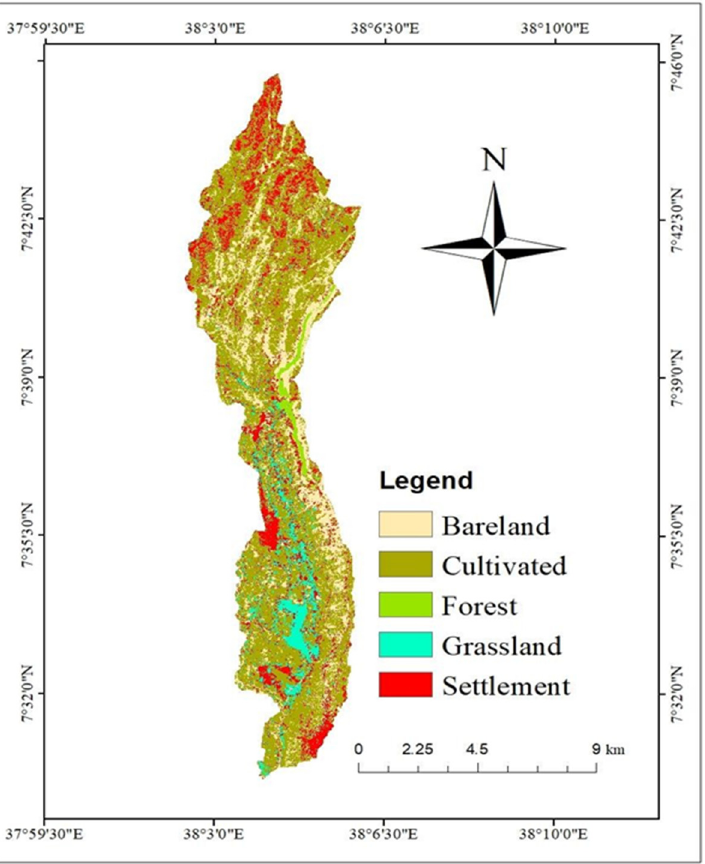
Figure 5. The LULC Map of 2020 Matenchose watershed.